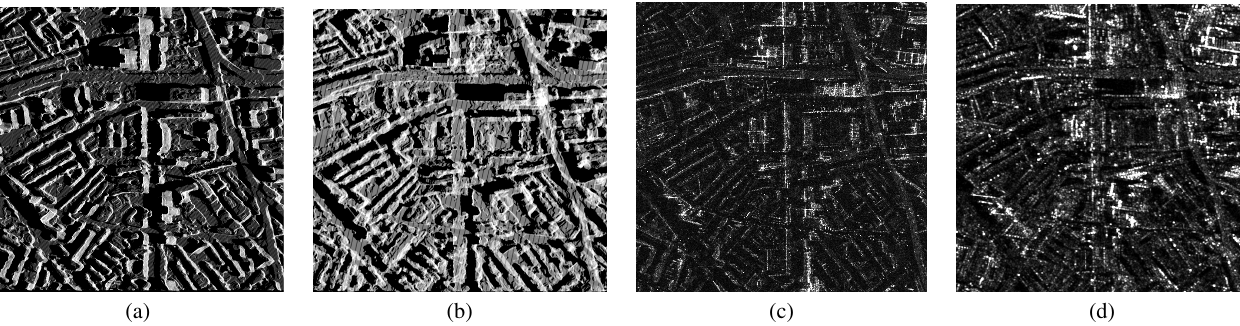
Figure 3. Simulation for Viktualienmarkt in Munich, using the DSM generated from LiDAR data (a) and the preprocessed DSM generated from WorldView-2 data (b). Image (c) shows the corresponding TerraSAR-X image acquired on June 7th, 2008.